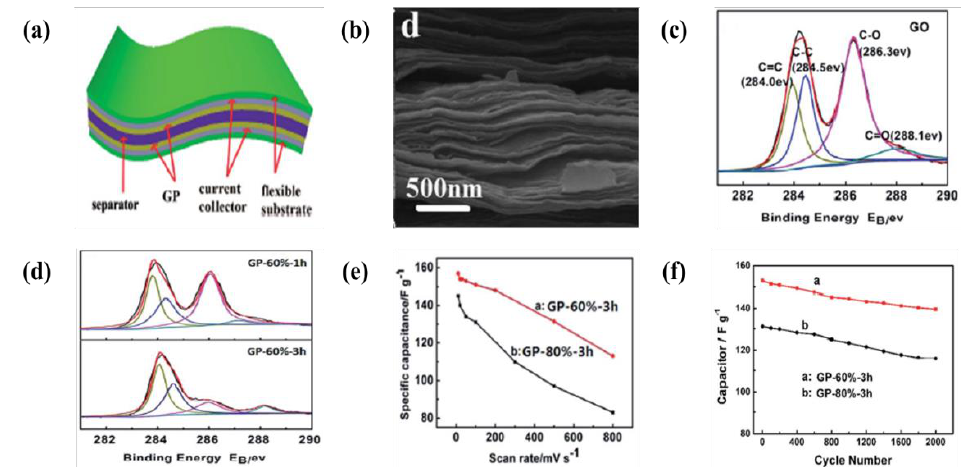
Figure 18. ( a ) Flexible graphene paper supercapacitor; ( b ) SEM image of a graphene electrode prepared at a 60% duty ratio for 3 h; ( c ) XP spectra of graphene oxide; ( d ) XP spectra of graphene electrode prepared at a 60% duty ratio for 3 h; ( e ) Specific capacitance of graphene electrode prepared at a